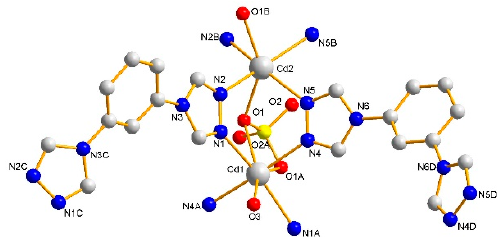
Figure 1. The coordination environments of the Cd(II) atoms in compound 1 . [Symmetry codes: (A) – y +3/2, – x +3/2, – z +3/2; (B) y , x , – z +1; (C) – x +2, y , z ; (D) x , – y +1, z